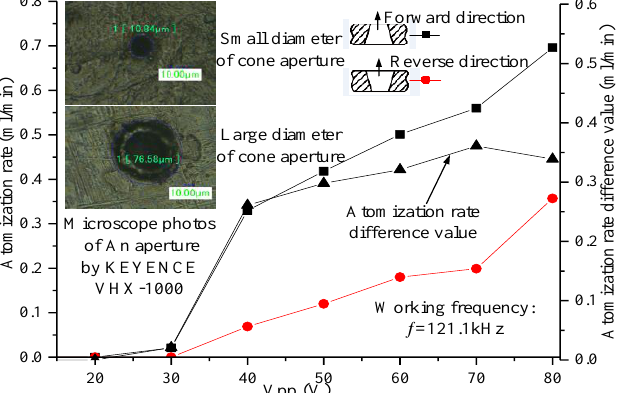
Figure 9. Variation in the atomization rate and the atomization rate difference values with applied voltage when the micro-tapered aperture atomizer is operating in the forward and reverse directions. In the test described above, the atomization rate measured in the forward direction is much higher than that measured in the reverse direction, which indicates that the micro-tapered aperture plays an important role in the atomization process. When the liquid is located in the flared side of the